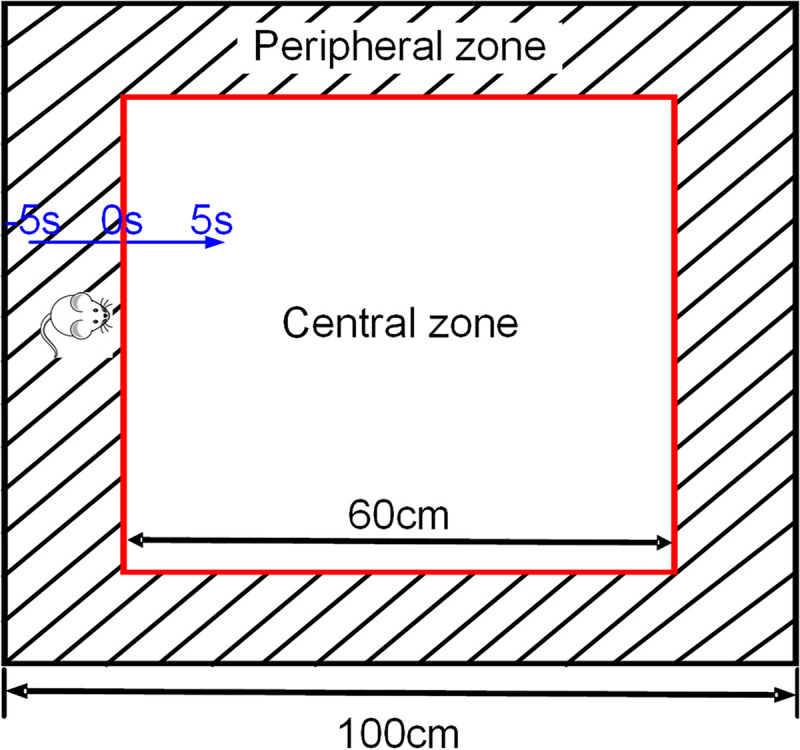
Schematic representation of exploratory behavior in OFT. The black square refers to the four walls of the open field, and the red square in the middle is the central area (only for video analysis). The area between the two squares is the peripheral zone. The blue one-way arrow indicates that the rat moves from the peripheral to the central zone, and the black two-way arrow is used to describe the size of the open field.